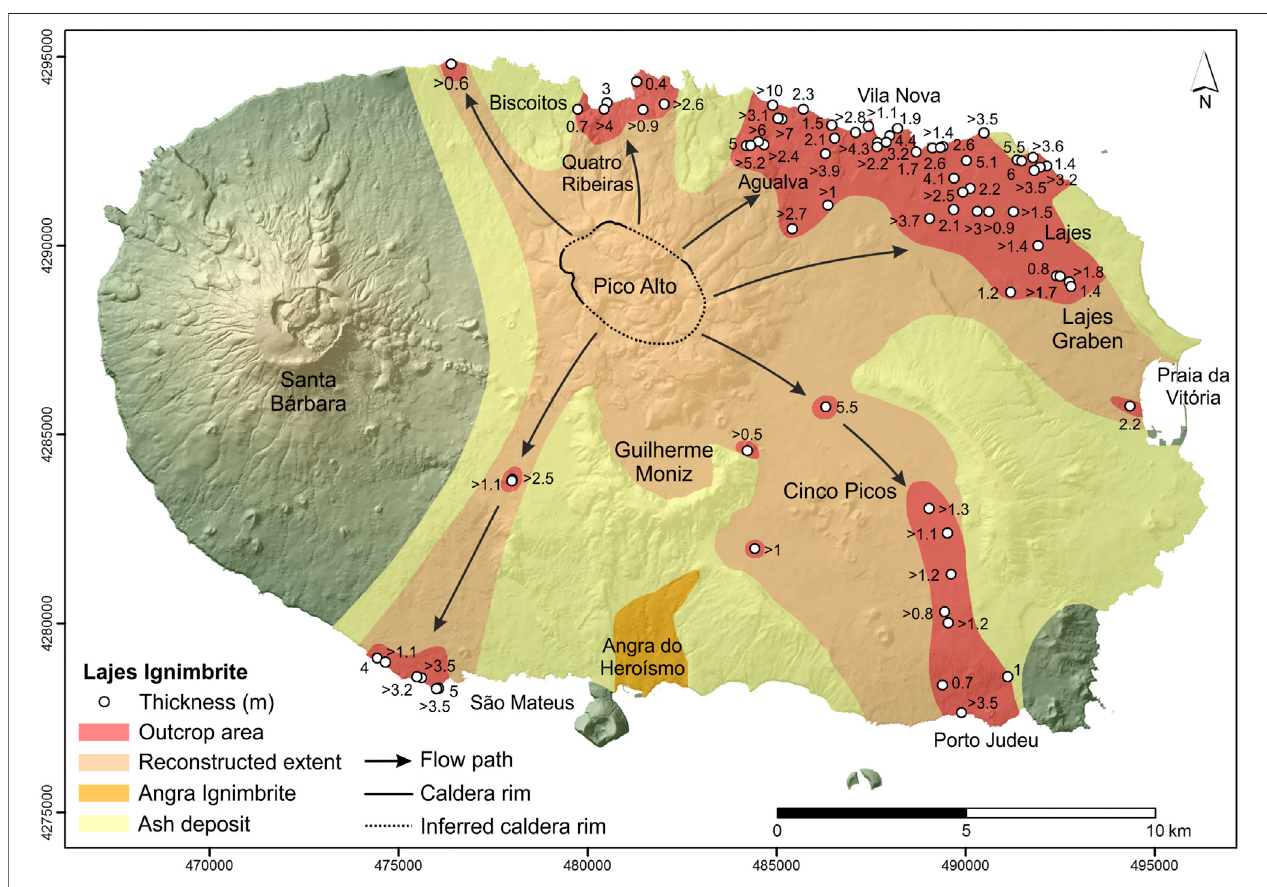
FIGURE 4 | Distribution map of the Lajes Ignimbrite, including documented stratigraphic sections (white circles). Arrows indicate the main fl ow paths; Locality names referred throughout the text are shown; UTM coordinates, zone 26S.